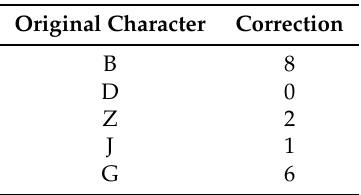
Table 4. Character correction based on